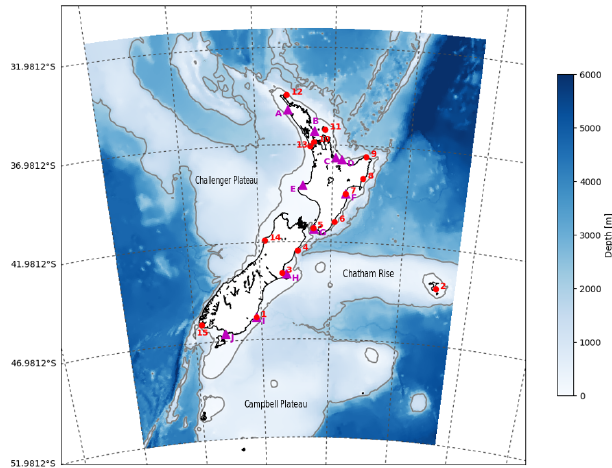
Figure 1. Moana Ocean Hindcast domain and bathymetry and coastal observation locations of daily water temperature (magenta triangle) and tide gauge sea level measurements (red dots) for use in model–data comparison (Sect. 3.4). Temperature locations are sequentially lettered ( A – J ) from north to south. Land Information New Zealand (LINZ) tide gauge stations are numbered ( 1 – 15 ) to follow anticlockwise Kelvin wave propagation from the southeast station (Port Chalmers) to the southwest (Puysegur). The grey con- tours show the positions of the 200 and 2000m